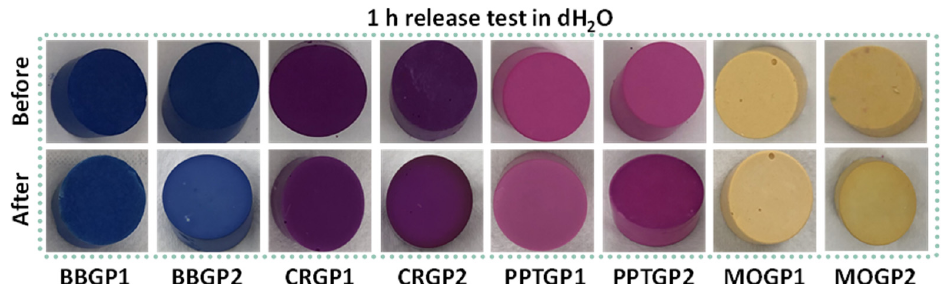
Figure 6. Images of coloured geopolymers before and after 1 h of release in water. Figure 6 . Images of coloured geopolymers before and after 1 h of release in water.